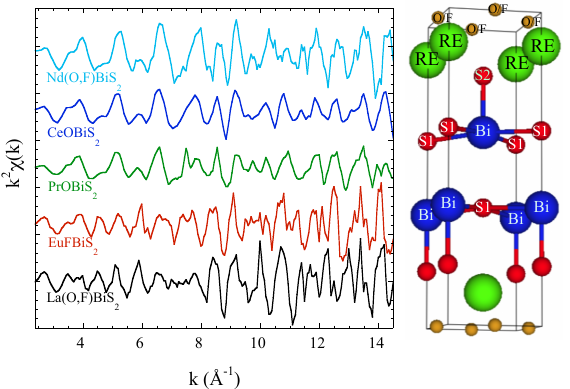
Figure 1. EXAFS oscillations of RE(O/F)BiS 2 single crystals samples (RE = La, Eu, Pr, Ce, Nd) measured at Bi L 3 -edge with X-ray polarization parallel to the crystallographic ab-plane. The oscillations are weighed by k 2 to amplify the signal at higher k-values and vertically shifted for a better visualization. The crystal unit cell of RE(O/F)BiS 2 is also